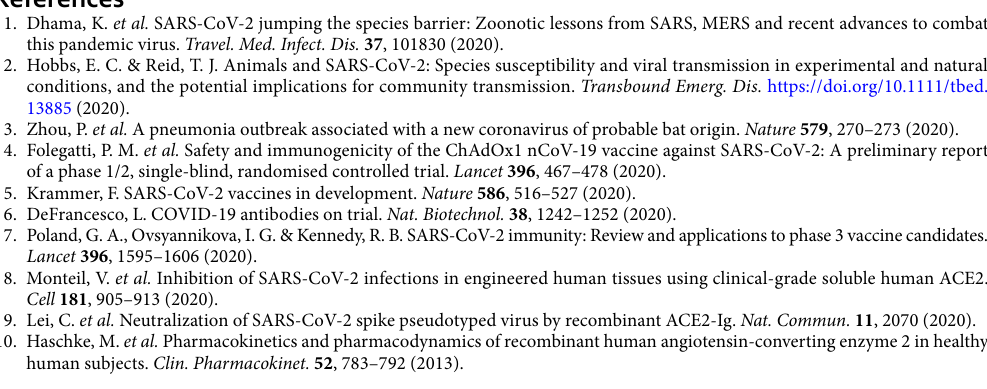
Figure 5. Tetrameric ACE2-Fc-TD out competes dimeric ACE2-Fc in viral neutralization assays. The neutralizing potency of tetrameric ACE2-Fc-TD Quad in inhibition of viral infection was examined in pseudovirus and live SARS-CoV-2 infection assays. ( A , B ) Lentiviral pseudotyped virus expressing SARS-CoV-2 spike protein were combined with SAD-S35 (AcroBiosystems), with ACE2-Fc, or with ACE2-Fc-TD and added to HEK 293 T/17 cells expressing ACE-2 and TMPRSS2 after 1 h. The cells were incubated for 60 h before luciferase activity, indicative of viral entry, was determined. ( C , D ) Further compares the neutralization of ACE2- Fc-TD, with H4-Fab-TD or with B38-Fab-TD. IC 50 data ( E ) were calculated using GraphPad Prism software and compare the efficacy of the two forms of soluble ACE2 proteins with the commercially available anti-SARS- CoV-2 antibody SAD-S35 and tetramerized anti-SARS-CoV-2 Fab antibodies H4 and B38 14 . ( F ) ACE2-Fc (dimeric for ACE2) and ACE2-Fc-TD (tetrameric for ACE2) proteins were preincubated with SARS-CoV-2 for 30 min at 37 °C. Vero E6 cells were infected with the ACE2-virus mixtures for 1 h at 37 °C before washing and continued incubation for 15 h at 37 °C. Cells were recovered and viral RNA was assayed by qRT-PCR. The graph shows relative fold change of viral RNA based on the Ct values compared to cellular RNA levels of mock infected cells. Data are represented as mean ± SD. (Student’s t test: ****P < 0.0001 p * <